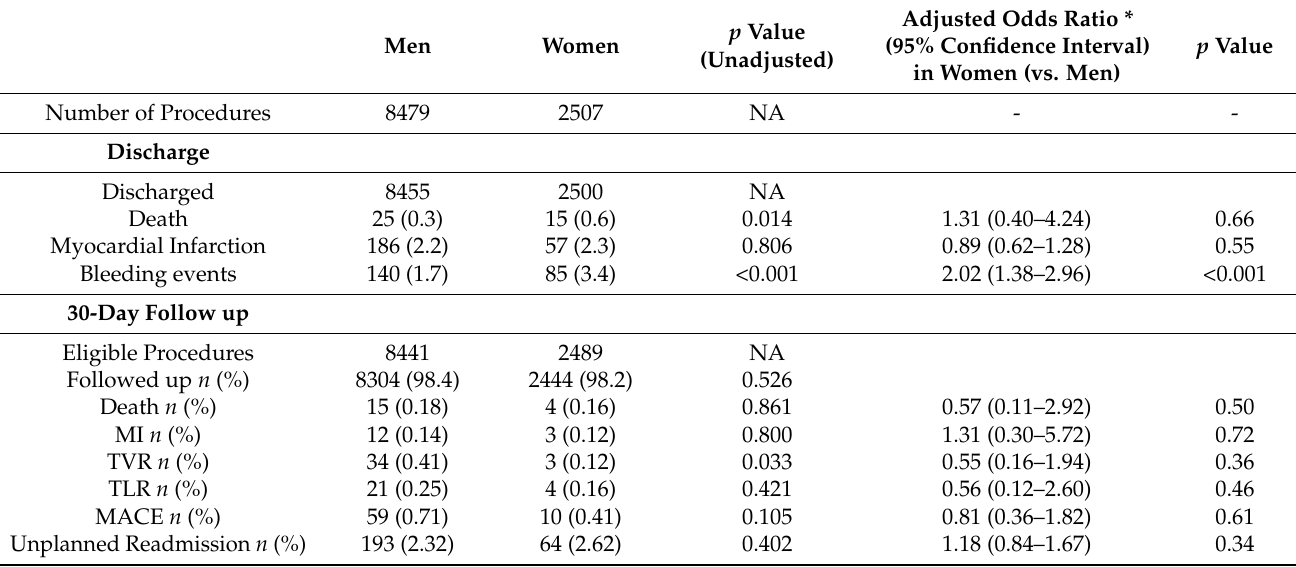
Table 3. Clinical events and outcomes at discharge and